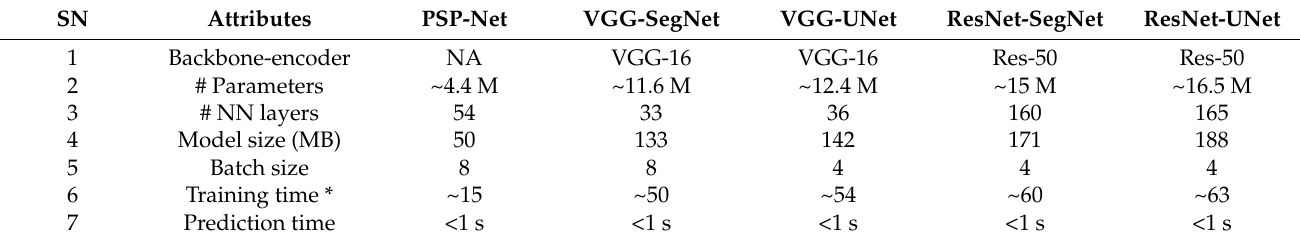
Table 4. Parameters for the five AI